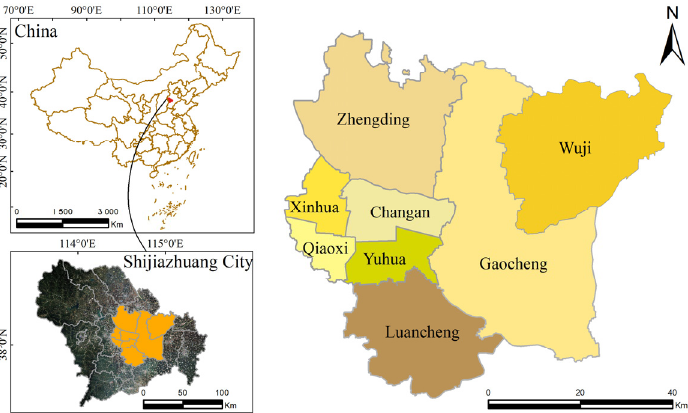
Figure 1 . Location of the study area. Figure 1. Location of the study